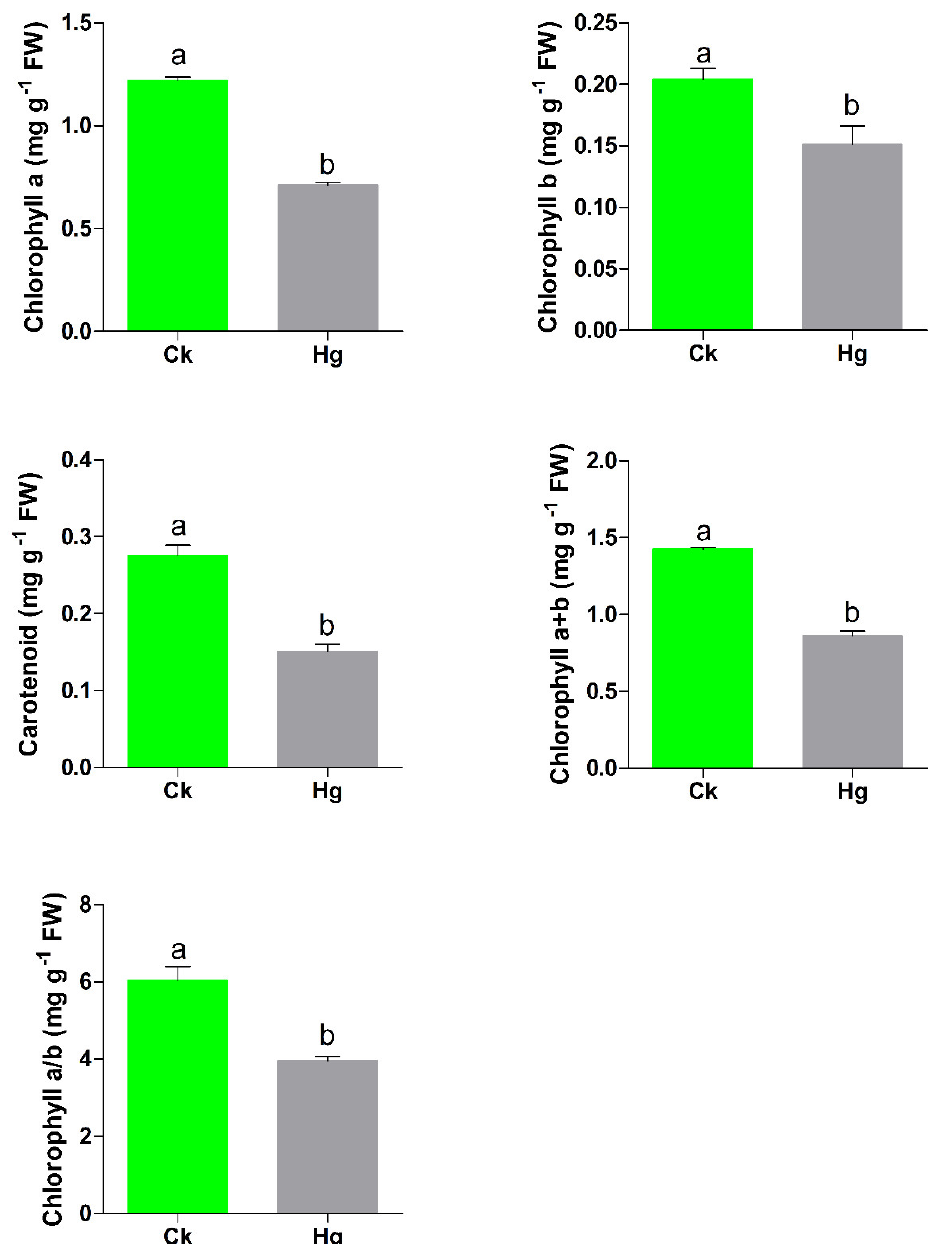
Figure 1. The effects of Hg stress on the chlorophyll content in Chinese cabbage seedlings. Different letters above the bar indicate significant difference at p < 0.05.